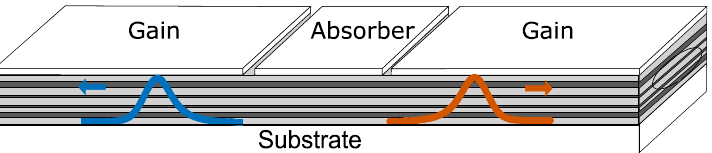
Fig. 1. (a) An example of multi-section Fabry-Perot (FP) cavity geometry, consisting of spatially separated gain (G) and absorber (A) regions for colliding pulse mode locking.